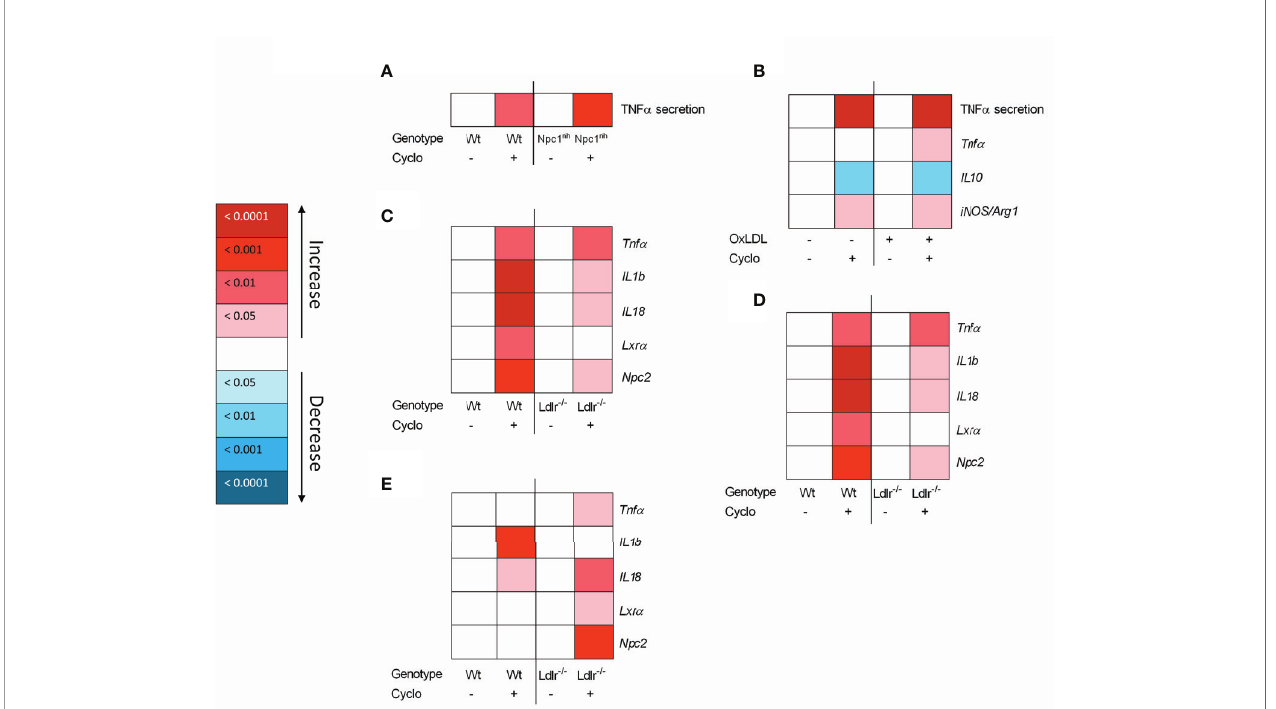
FIGURE 4 | Metabolically-challenged BMDM parameters of in fl ammation and cholesterol metabolism after four hour incubation with 2-hydroxypropyl- b -cyclodextrin. (A) TNF a protein levels of 2-hydroxypropyl- b -cyclodextrin (1.95 mM; 4hr)-treated Wt or Npc1 nih BMDM that were terminally stimulated with LPS (100ng/ml; 4hr). (B) TNF a protein levels and Tnf a , IL10 and iNOS/Arg1 ratio gene expression data of oxLDL (25µg/ml; 24hr)-exposed Npc1 nih BMDM treated with or without CD (4hr) that were terminally stimulated with LPS (100ng/ml; 4hr). Gene expression data were set relative to control-exposed Npc1 nih BMDM treated with saline and stimulated with LPS. (C – E) Gene expression analysis of Tnf a , IL-1b, IL-18, Lxr a and Npc2 of oxLDL (25µg/ml; 24hr)-exposed Ldlr -/- and Wt BMDM treated with or without CD (1.95 mM; 4hr) and terminally stimulated with control (C) , Pam3Cys (4hr) (D) or LPS (4hr) (E) . Gene expression data were set relative to oxLDL-exposed Wt BMDM treated with saline. Colored (red or blue) boxes are compared to the box directly at their left via two-way ANOVA followed by Tukey post-hoc analysis, indicating the effect of CD. Data are the result of 2 or 3 independent